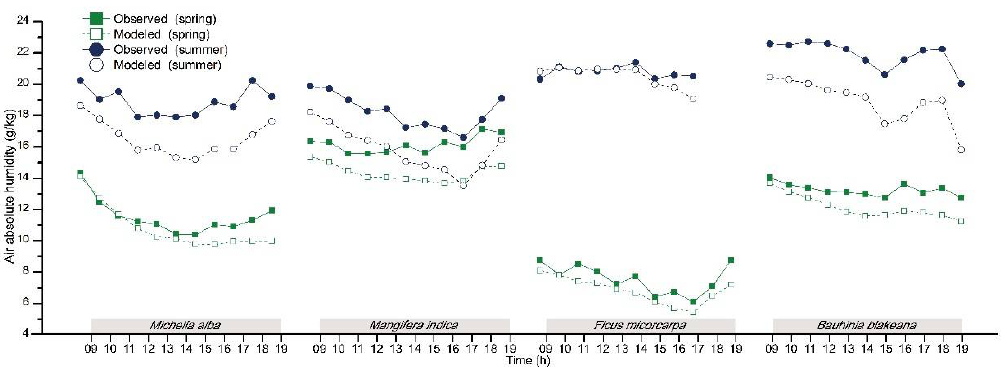
Figure 11. Comparison of modeled and observed air absolute humidity in canopy shade areas.